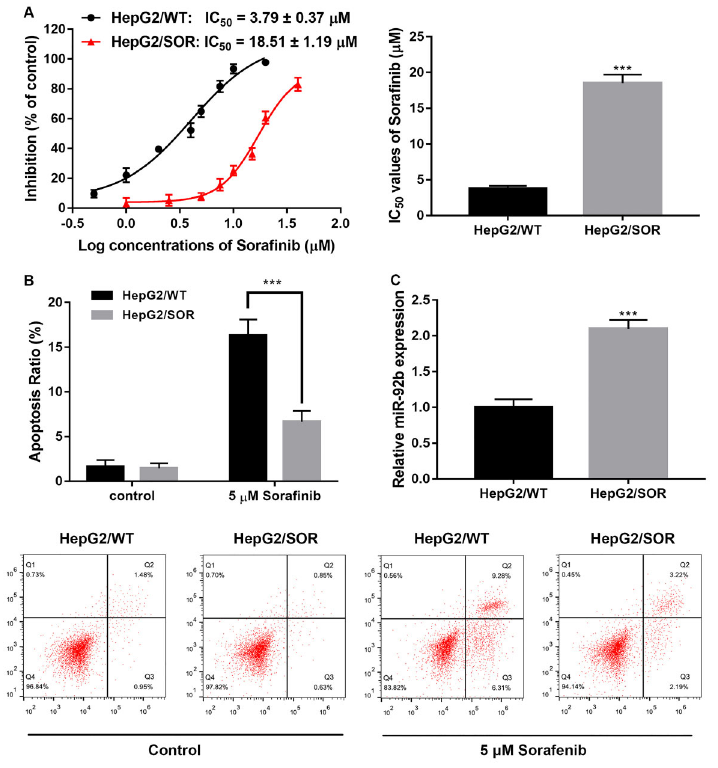
Figure 1. miR-92b is overexpressed in sorafenib-resistant HepG2 cells. A , Rates of inhibition and half maximal inhibitory concentration (IC 50 ) values of sorafenib (SOR) in HepG2/SOR or HepG2/WT (wild type) cells. B , Flow cytometry was conducted to measure the apoptosis of HepG2/SOR and HepG2/WTcells treated with SOR (0.5 m M). C , qRT-PCR analysis of miR-92b expression in HepG2/WTor HepG2/SOR cells. Data are reported as means ± SD, ***P o 0.001 (Student ’ s t